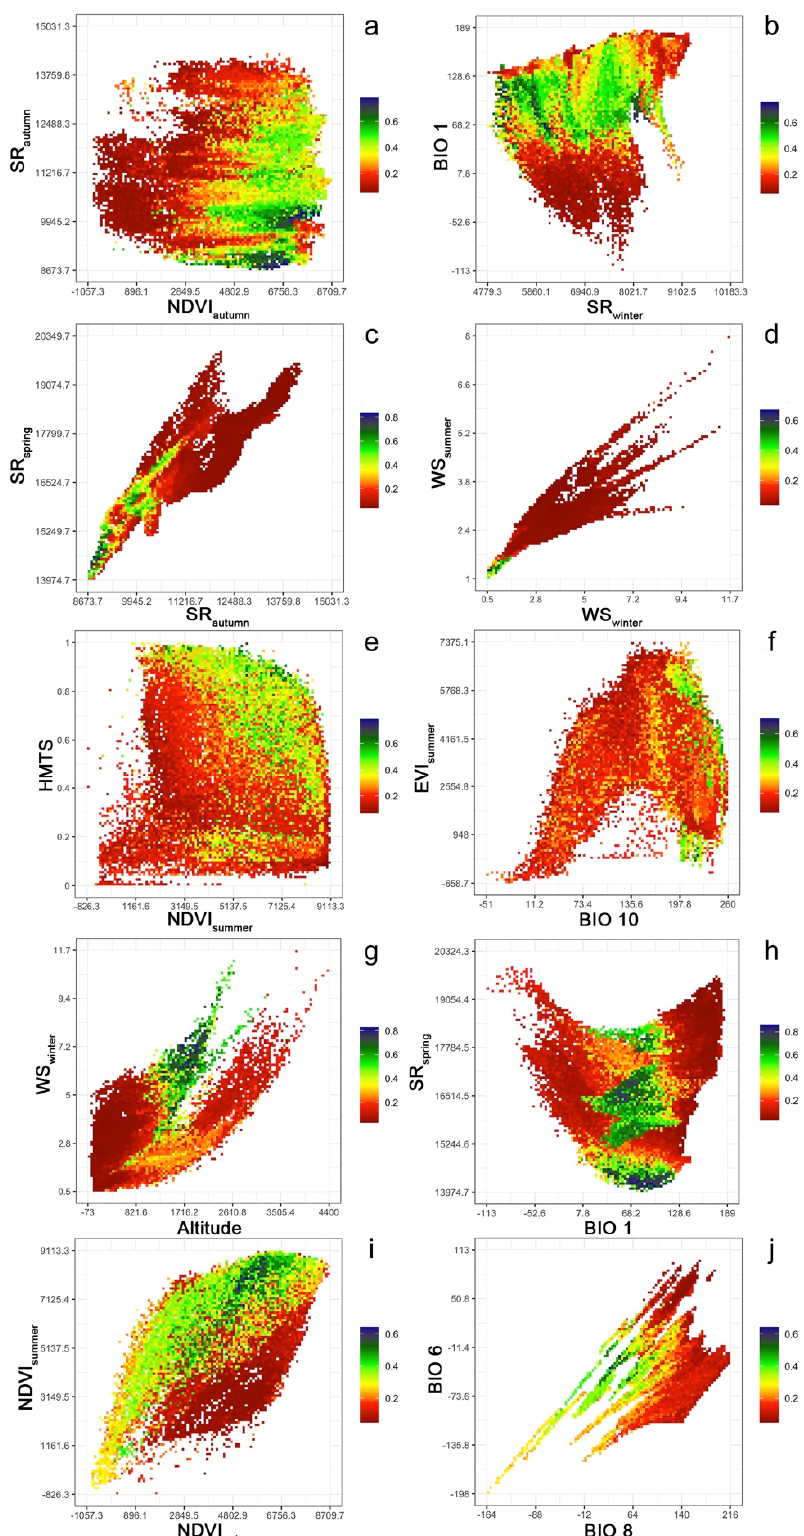
Figure 2. Graphical representation of the niche space for the big five : ( a , b ) Morimus asper asper/funereus , ( c , d ) Lucanus cervus , ( e , f ) Cerambyx cerdo , ( g , h ) Rosalia alpina and ( i , j ) Osmoderma spp. The colour scale indicates habitat suitability (HS) according to a two-dimensional environmental space, based on the selected predictors, from low HS (dark red) to high HS (dark blue). Environmental variables are reported in the following units: solar radiation (SR) (kJ/(m 2 ×day)); wind speed (WS) [m/s]; BIO1, BIO6, BIO8 and BIO10 (°C × 10), altitude (m asl). Human modification of terres-